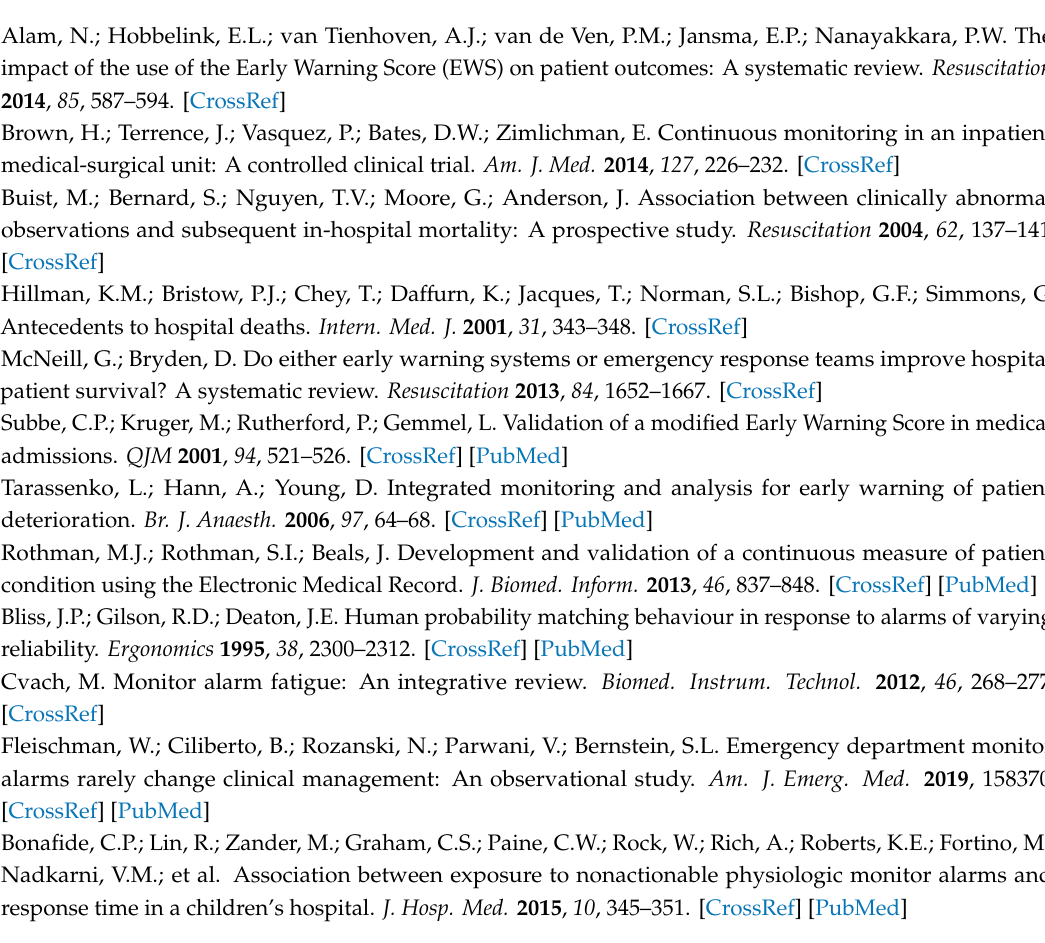
Figure S1: Sensitivity and Specificity of Classical MEWS at Di ff erent Thresholds; Figure S2: Rate of Escalation by MDC; Figure S3: Sub-group analysis of MEWS ++ Performance by Major Diagnostic Category (MDC); Figure S4: Top Features contributing to model, ranked by Gini coe ffi cient; Table S1: Phenotyping Rules; Table S2: Model Parameters; Table S3: Initial List of Features (Variables); Table S4: Final List of 36 Features (Variables) Chosen by Recursive Feature Elimination; Table S5: Results of 10-fold under-sampling of training data on final RF model